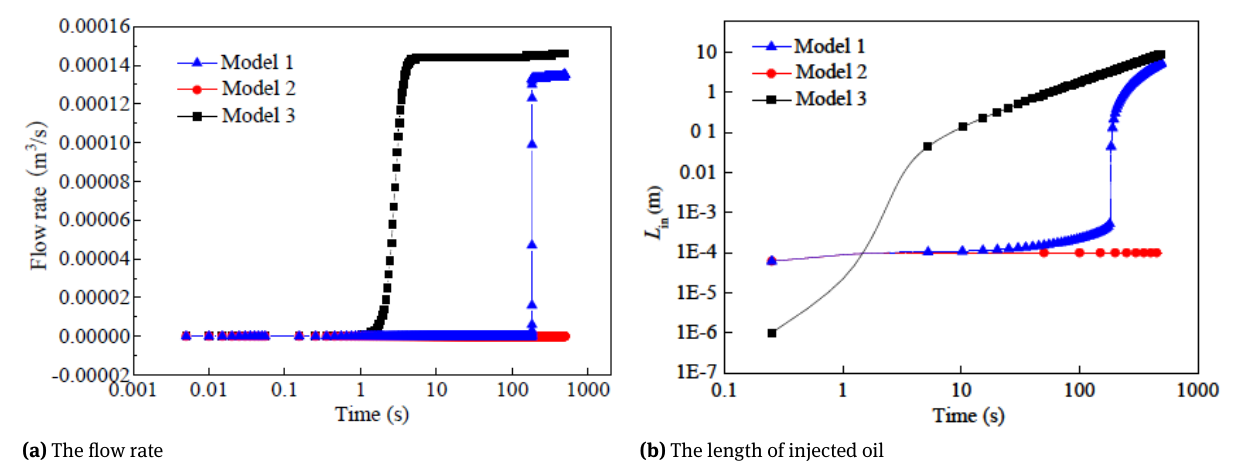
Figure 15: The calculated flow rate and length of injected oil under one pump condition